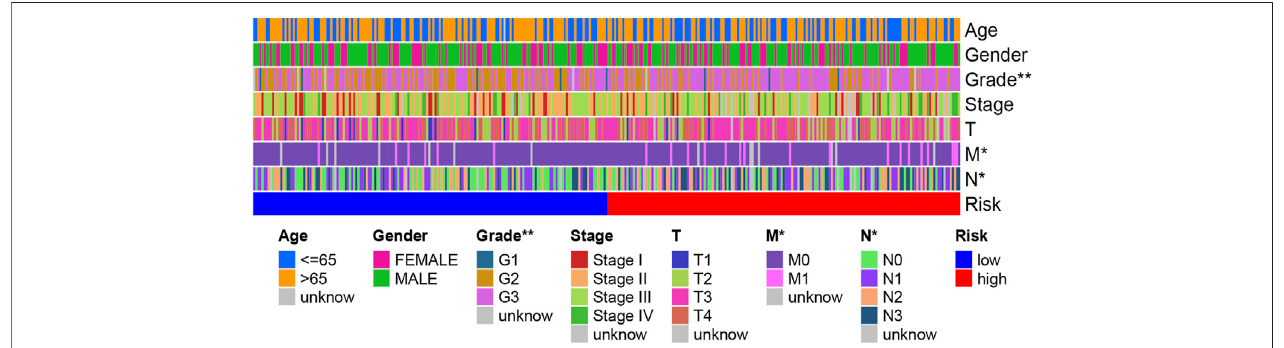
FIGURE11| Therapeuticbene fi tsofriskscorescalculatedbyourmodel.Violin plotillustrates theriskscoredistributionsforpatients withGCin (A) TIDEscore, (B) T-cell dysfunction score, and (C) T-cell exclusion score. (D) ROC curves of our model compared with TIDE and TIS scores. (E) Time-dependent ROC curves of immunotherapy response prediction at 1-, 2-, and 3- year survival rates based on the risk scores for GC.